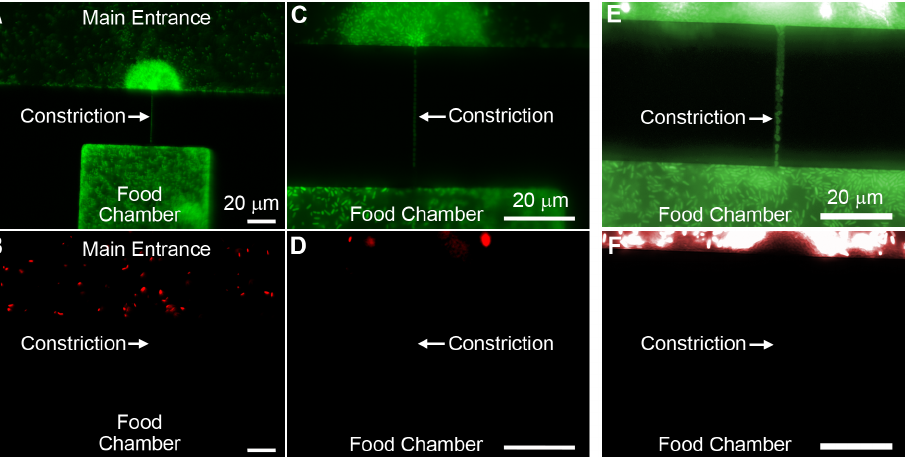
Figure 3. Isolation of pure bacterial cultures from heterogeneous populations. (a-d) Food chamber connected to an external environment containing CFP-labeled P. aeruginosa and RFP-labeled E. coli via a 700 nm tall, 1.5 m m wide, 40 m m long constriction. (a) GFP filter, 40x magnification. (b) RFP filter, 40x magnification. E. coli are only observed in the main entrance. (c) GFP filter, 100x magnification. A single column of P. aeruginosa cells is in the constriction. (d) RFP filter, 100x magnification. (e-f) Food chamber connected to an external environment containing GFP-labeled and RFP- labeled E. coli via a 950 nm tall, 1.5 m m wide, 40 m m long constriction. (e) GFP filter, 100x magnification. A single column of GFP-labeled cells is visible. (f) RFP filter, 100x magnification. No RFP-labeled cells are visible in the constriction or food chamber.